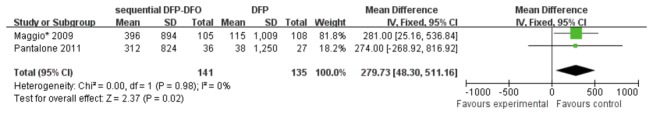
Forrest plot for the decrease of SF between sequential DFP with DFO group and DFP group.